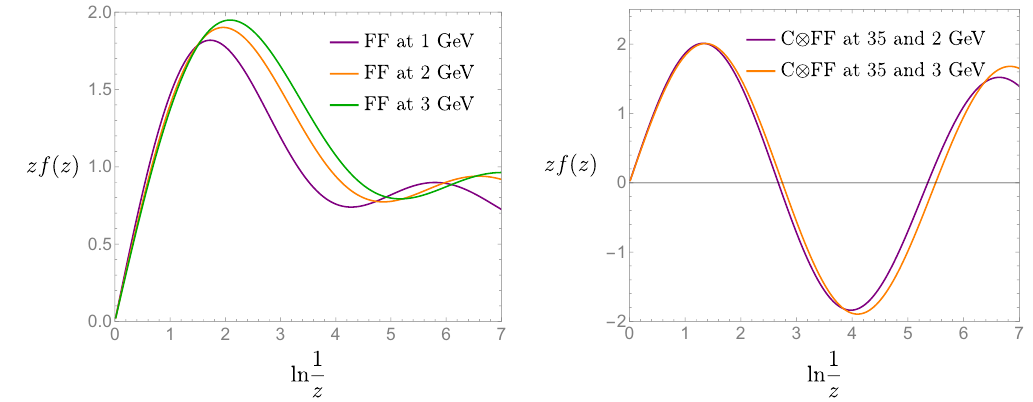
Figure 1 . On the left, I give the resummed fragmentation function of eq. (2.22) in momentum space evaluated at α (1 GeV ) , α (2 GeV ) , and α (3 GeV ) . On the right, I give the convolution of s s s the resummed fragmentation function with the resummed coefficient function, defined in eq. (2.36), with a hard scale of 35 GeV, and fragmentation scales of 2 and 3 GeV.